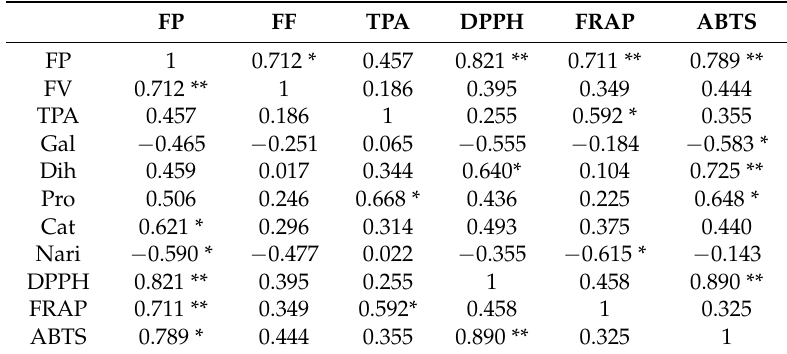
Table 5. Analysis of the correlation of the composition and free phenolic content with antioxidant